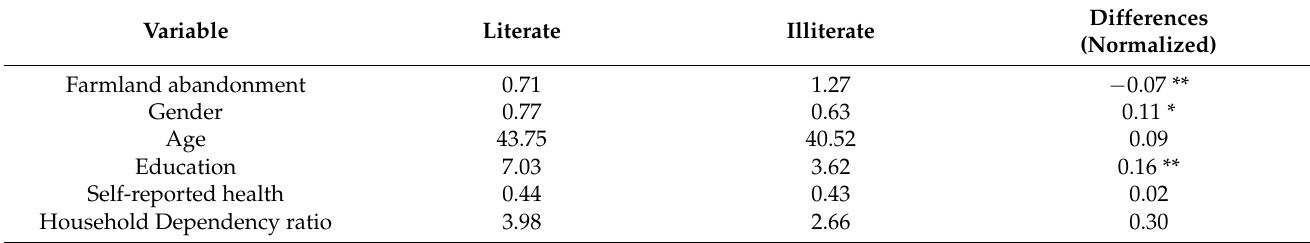
Figure 1. Distribution of average farmland abandoned by household income level and gender status. HH = Household. Table 2. Main variables mean differences between financial literates and